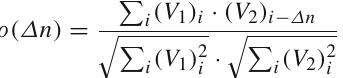
three waveforms (orange) to which random noise was added, resulting in a noisy signal (blue). The three waveforms are identical, except that channel 3 was shifted by 50 ns. The third row shows the correlations of these waveforms with a template, which is identical to the original waveform as well in this example. In the next step (fourth row) we com- bine two of these correlations by multiplying them with each other. Note that for channels 1 and 2 there is a sharp